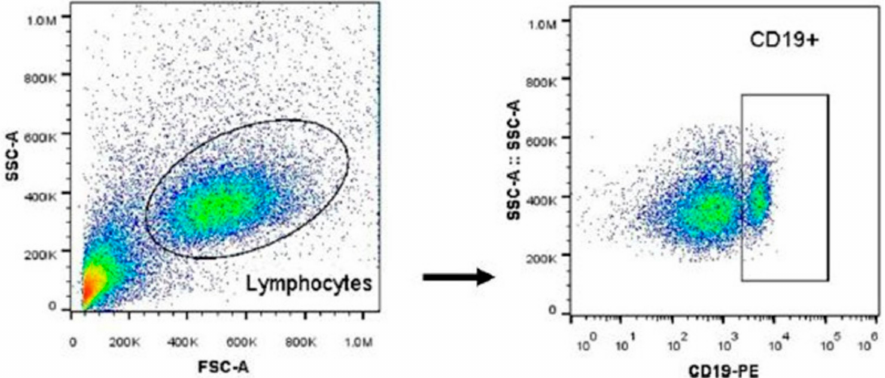
Figure 1. Strategy used for the identification of B lymphocytes. The dot plot is representative of the region of interest. Data analyzed with Flow Jo